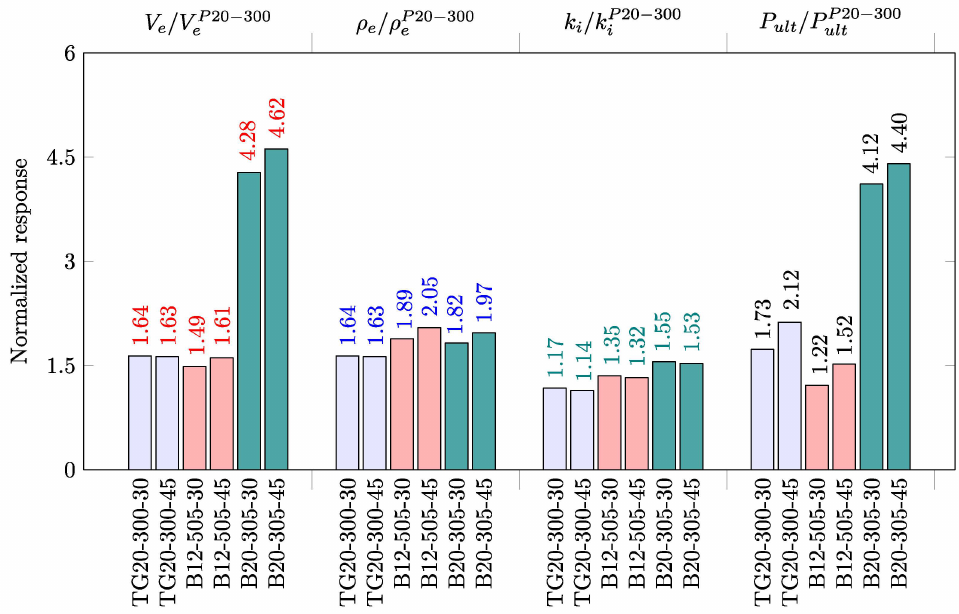
Figure 9. Effect of corrugation angle on the shear response of corrugated web beams (the exact values are provided at the top of each